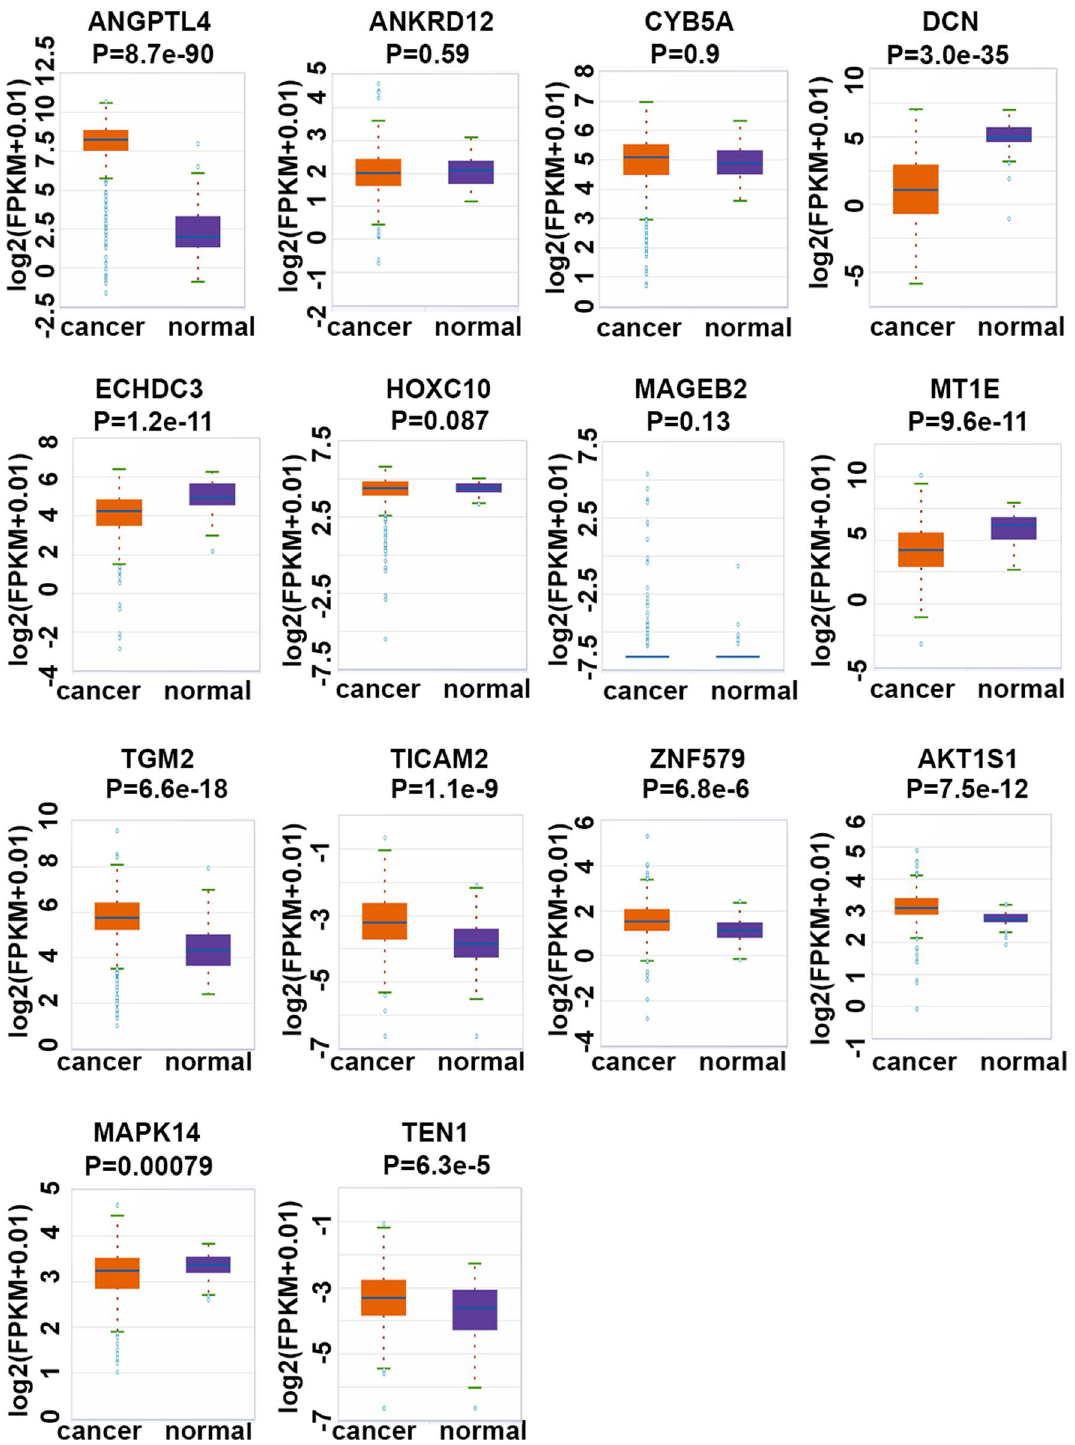
Figure 3. Expression of Fourteen Cigarette Smoke Exposure-related Genes in KIRC and normal kidney tissues in TCGA-KIRC dataset. The box plots of ANGPTL4, ANKRD12, CYB5A, DCN, ECHDC3, HOXC10, MAGEB2, MT1E, TGM2, TICAM2, ZNF579, AKT1S1, MAPK14, and TEN1 in KIRC tumor tissues (cancer, n = 531) and kidney normal tissues (normal, n = 72) from starBase database. Note: The gene-level transcription estimates was showed in a form of log2 (FPKM +